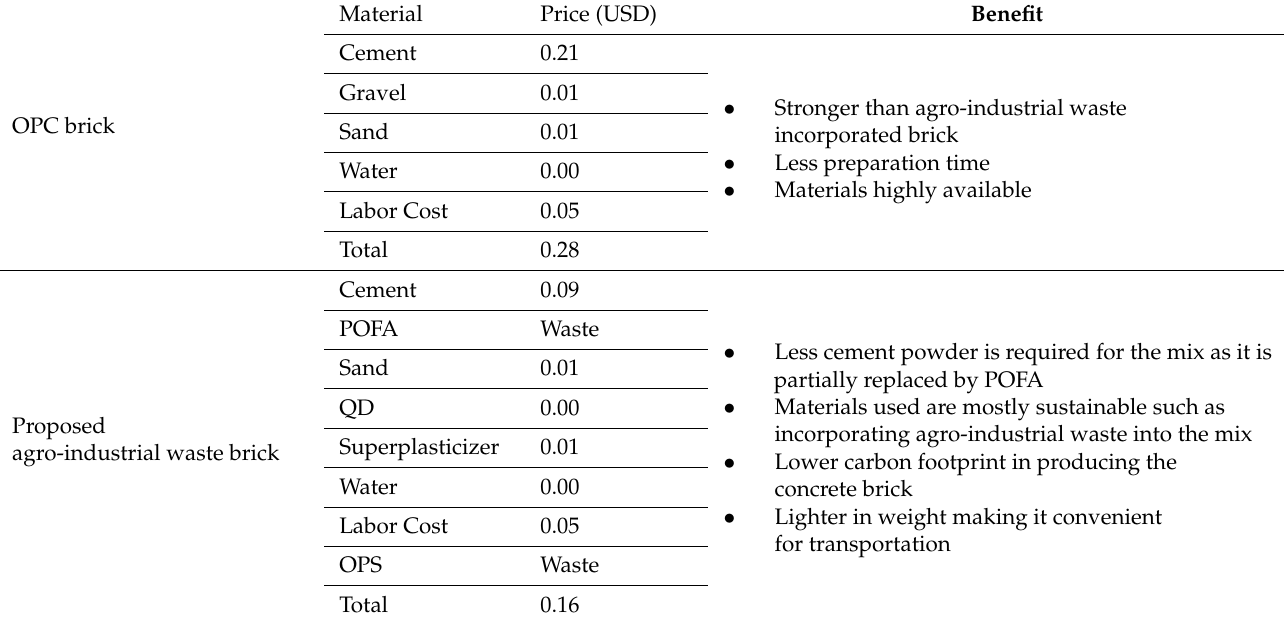
Table 9. Cost calculation of a single proposed